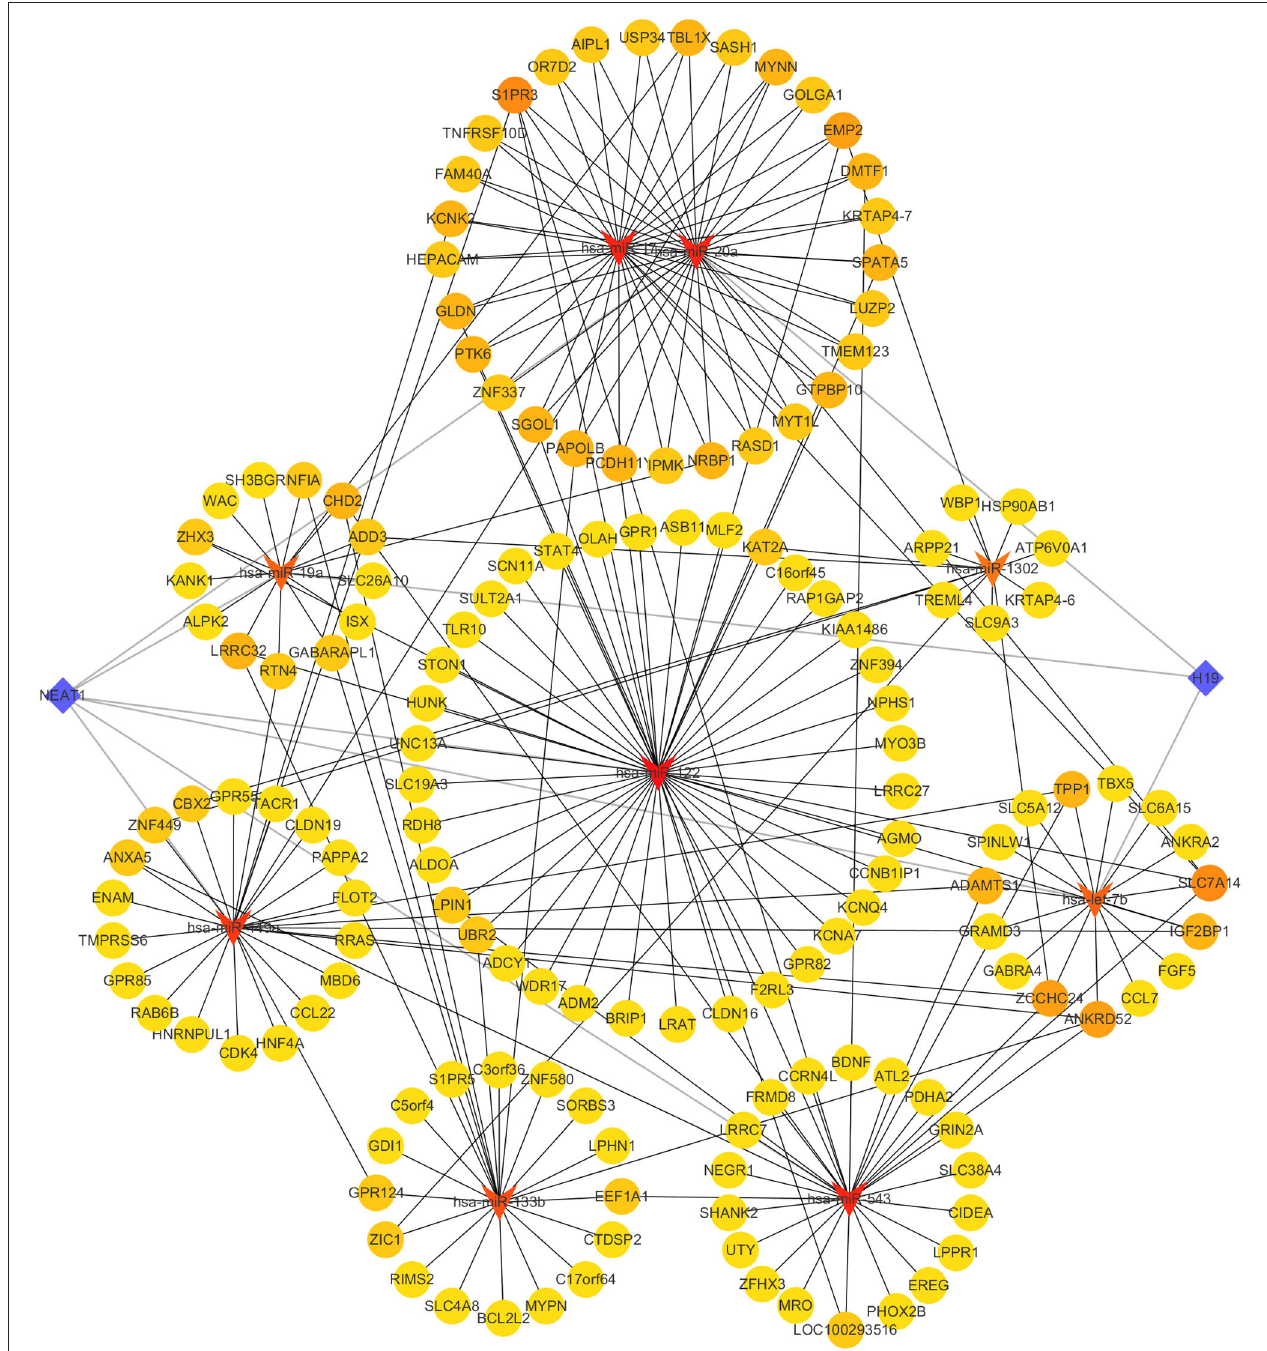
FIGURE 5 | The ceRNA regulatory network. Red triangles, yellow circles, and blue diamonds correspond to miRNAs, hub genes, and lncRNAs,